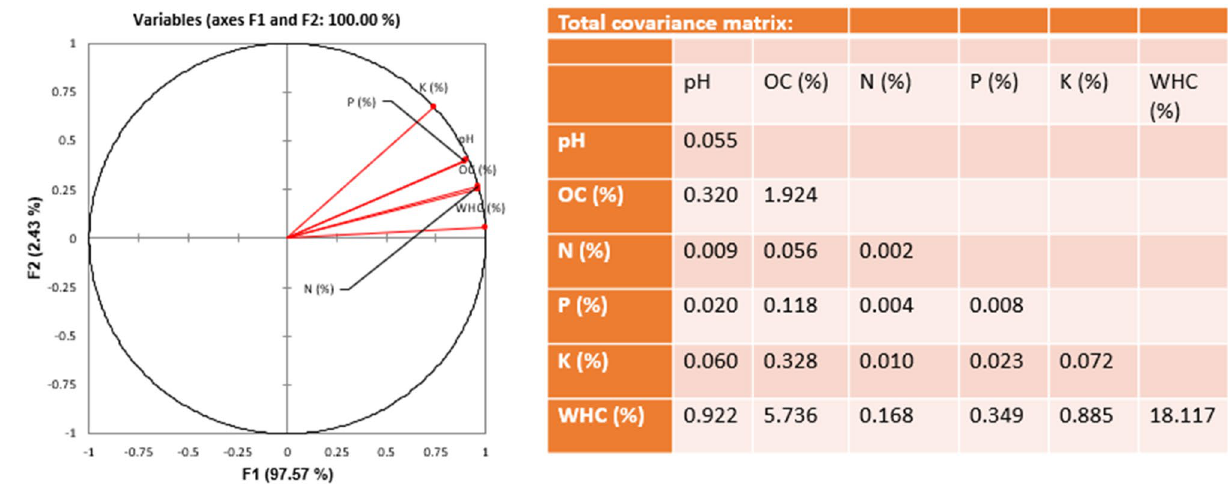
Figure 7. Discriminant function analysis of ( a ) direct field evaluated values, and ( b ) their covariance